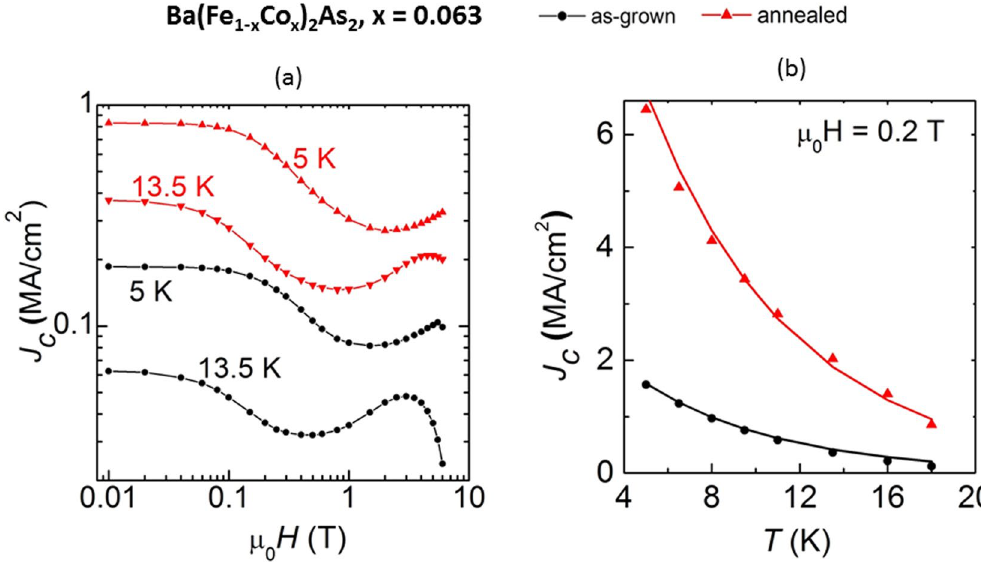
Figure 6. The increase in superconducting critical current density ( J c ) for annealed optimally-doped Ba(Fe 1 − x Co x ) 2 As 2 crystal. For x = 0.063 and as-grown (in black) and annealed (in red) crystals, ( a ) field dependence of critical current density ( J c ) below T c , and ( b ) temperature dependence of J c at 0.2